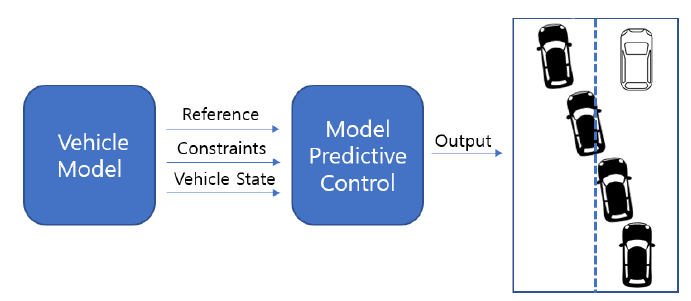
Figure 6. Generalized model predictive control